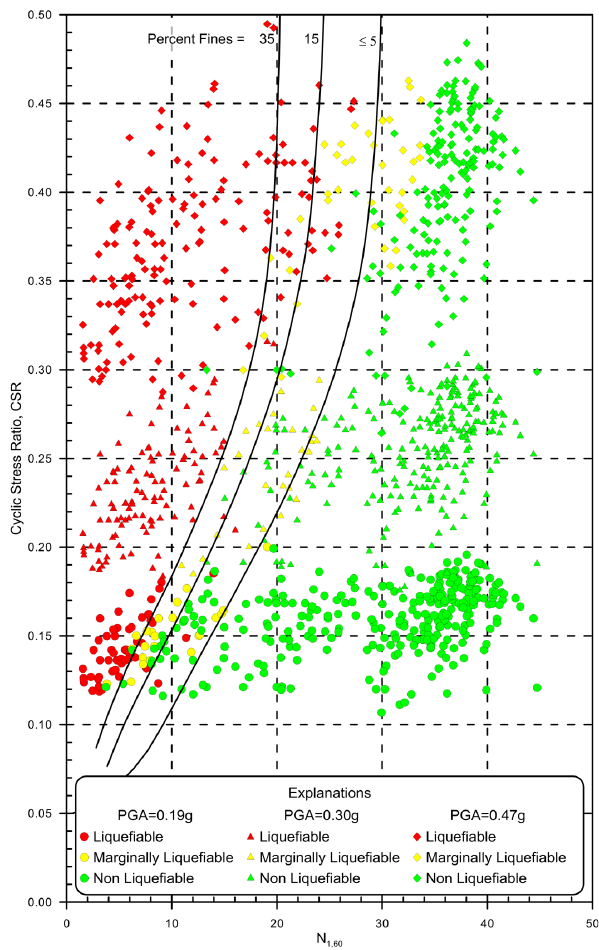
Fig. 9. Cyclic stress ratio and SPT N 1 , 60 plot based on Youd et al. (2001).